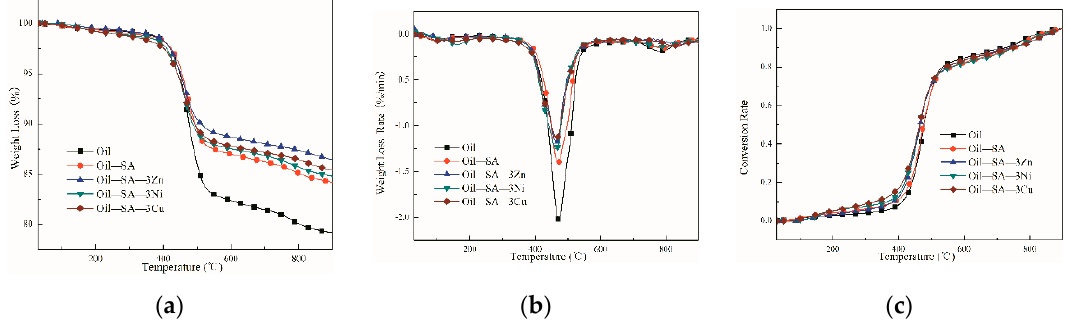
Figure 4. Thermogravimetric curves of OS with SA loading 3 wt% of ZnCl 2 , NiCl 2 ·6H 2 O and CuCl 2 ·2H 2 O: ( a ) TG; ( b ) DTG; ( c ) conversion rate.